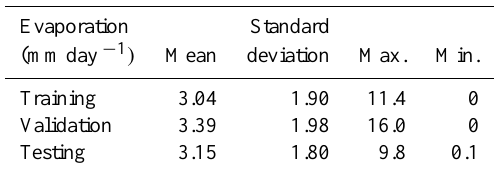
Table 2. Statistics of evaporation in training, validation and test